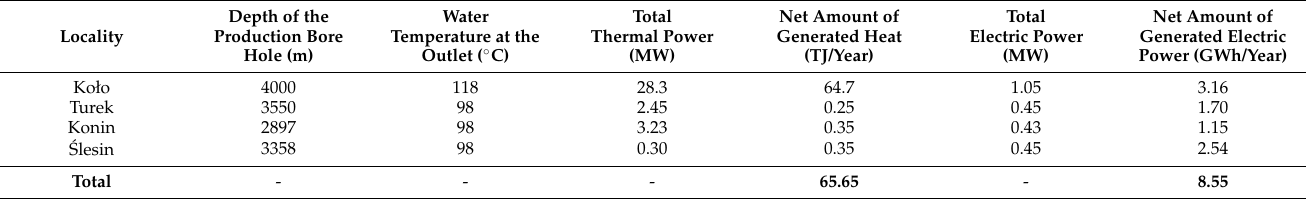
Table 3. Parameters of binary geothermal heat and power plants in the Greater Poland Voivodeship (net power value, taking into account own energy usage and loss) [98].